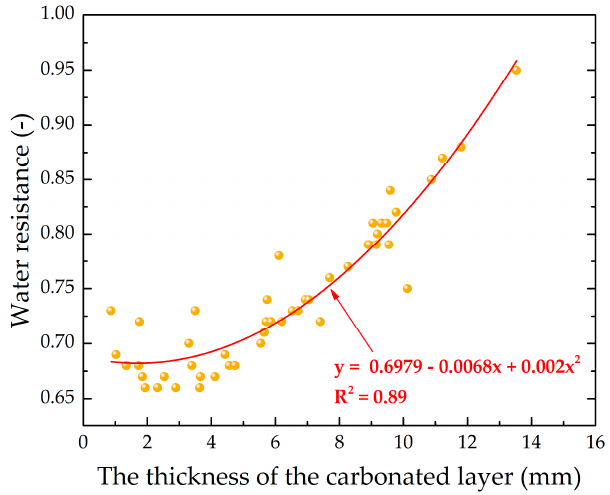
Figure 19. Dependence of water resistance on the thickness of the carbonated layer of lime-liming cylinder samples of semi-dry pressing on the basis of lime dust, obtained at 5 cycles of carbonation in the environment, with 40% concentration of CO 2 .